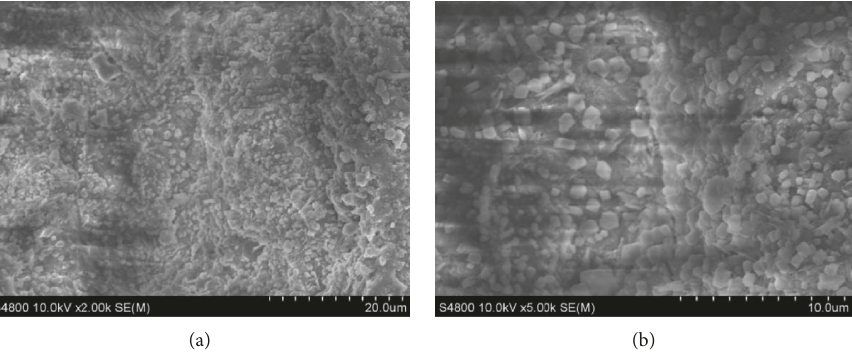
Figure 15: SEM of SJ10 (50%). Note: anhydrite is blocky.